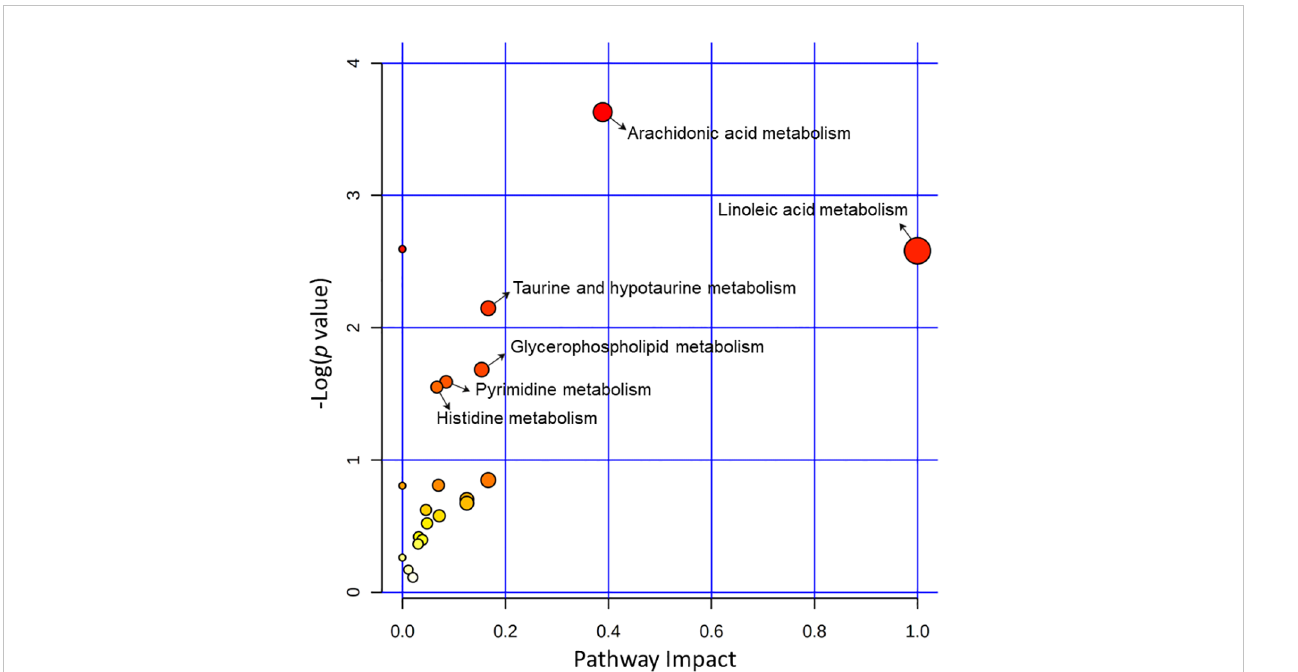
FIGURE 5 Pathway analysis of the identi fi ed differential metabolites between the acutely infected group (AI) and the noninfected group (Ctrl) in ESI − mode and ESI+ mode. Pathway impacts resulting from the differential metabolites were obtained using MetaboAnalyst 5.0. The magnitude of the enrichment